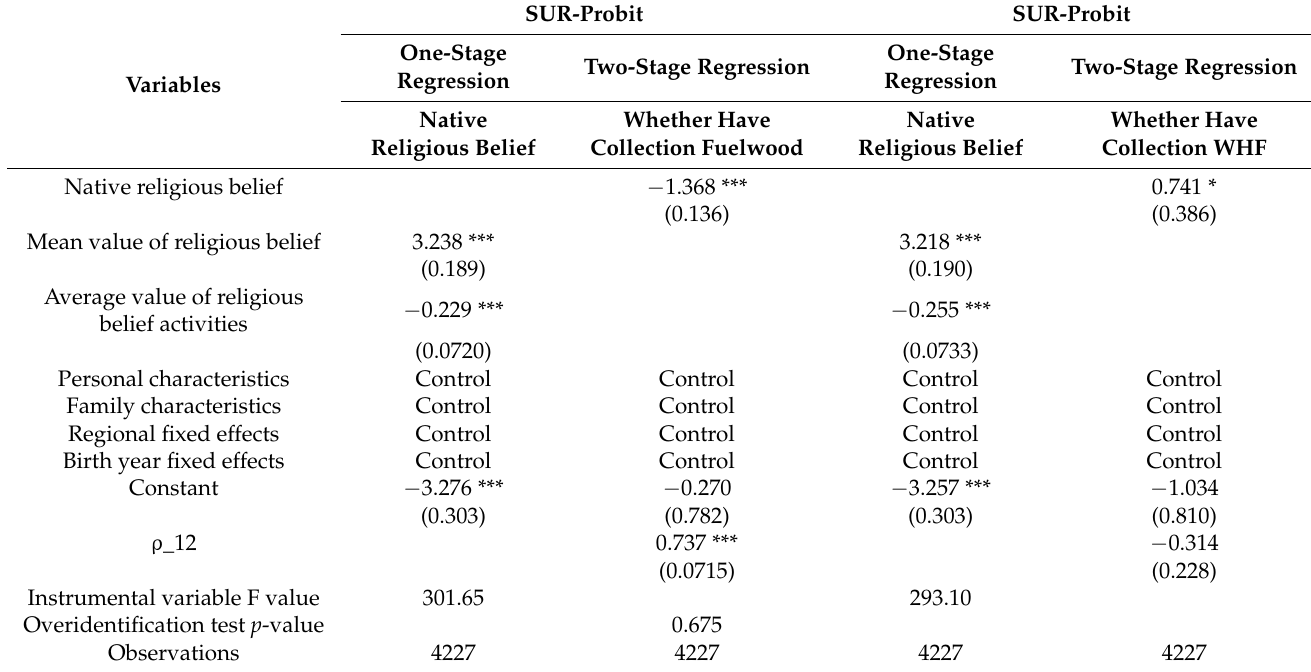
Table 10. Baseline regression for native religious belief and different NTFPs collection